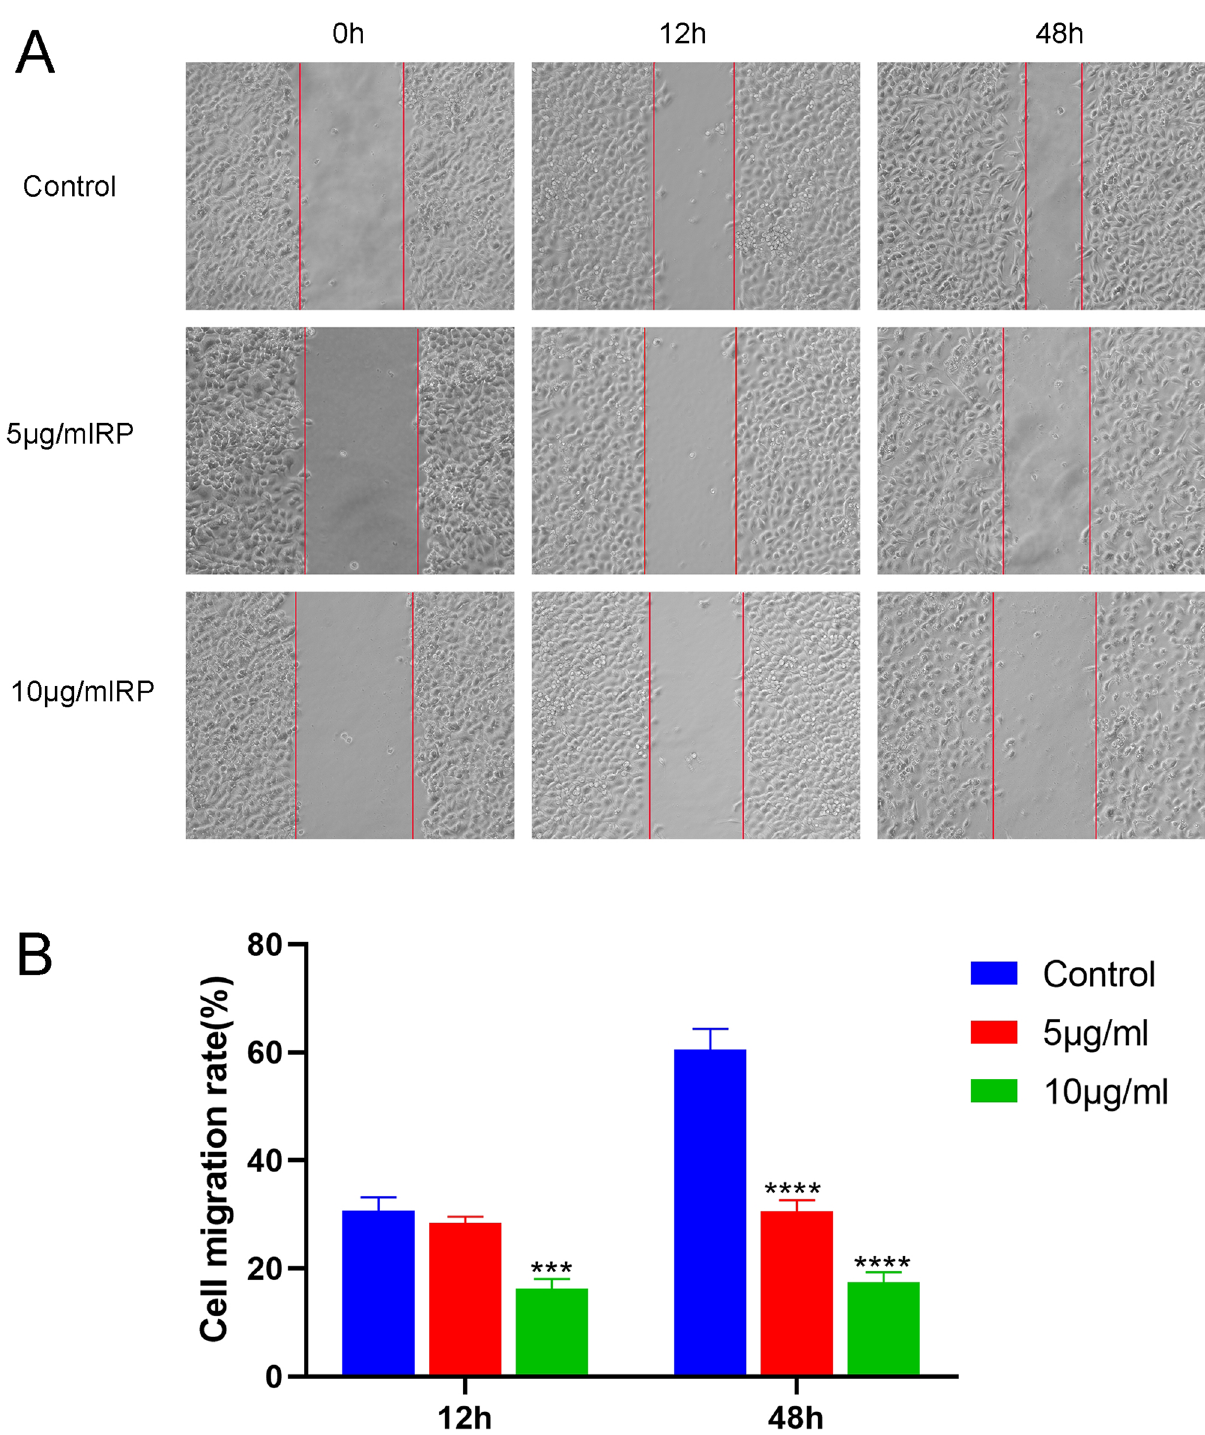
Figure 9. RP significantly inhibited the migration of SW480 cells. The effect of RP (0, 5, 10 μg/mL) on SW480 cell migration activity was examined under an inverted microscope to evaluate cell migration (40 ×). ( A ) Images during cell migration in scratch experiments. ( B ) The average scratch cell mobility at 12 h and 48 h after 5 μg/ mL and 10 μg/mL treatment. ***p < 0.001, ****p < 0.0001 compared with the control (0